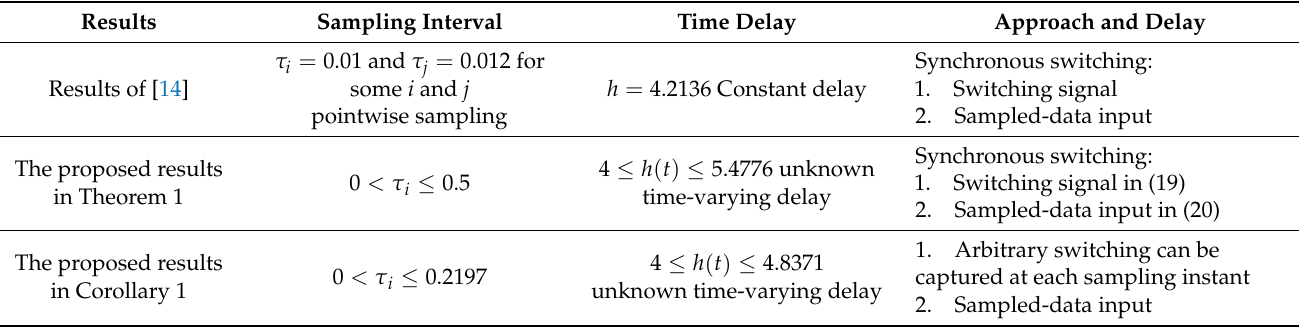
Table 2. Comparisons of the switched time-delay system (1) with (2) and